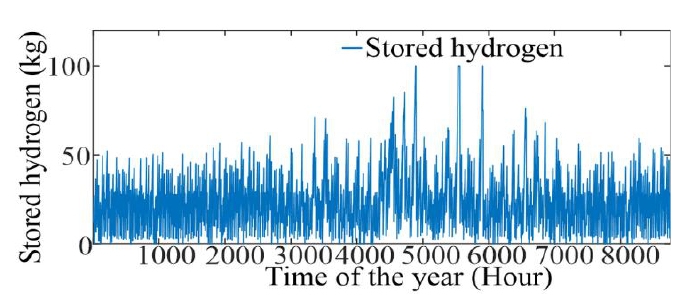
Figure 14. Hydrogen production over the year: combination 3.